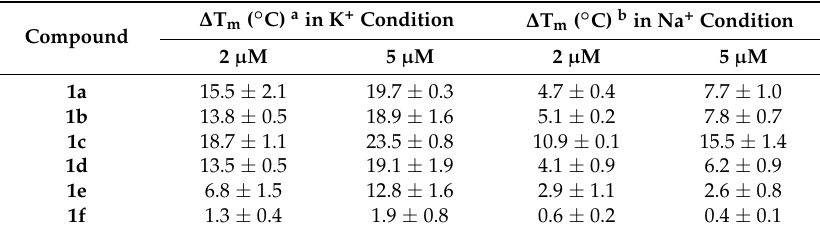
Table 2. FRET-melting values for compounds 1a – f with F21T in K + or Na + conditions.